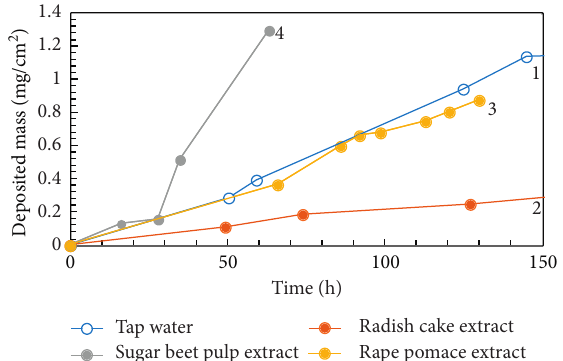
Figure 1: Scaling rate of mild steel in tap water at 100 ° C: (1) blank; (2) with 10mL/L of radish cake extract; (3) with 10mL/L of rape pomace extract; (4) with 10 mL/L of sugar beet pulp extract.